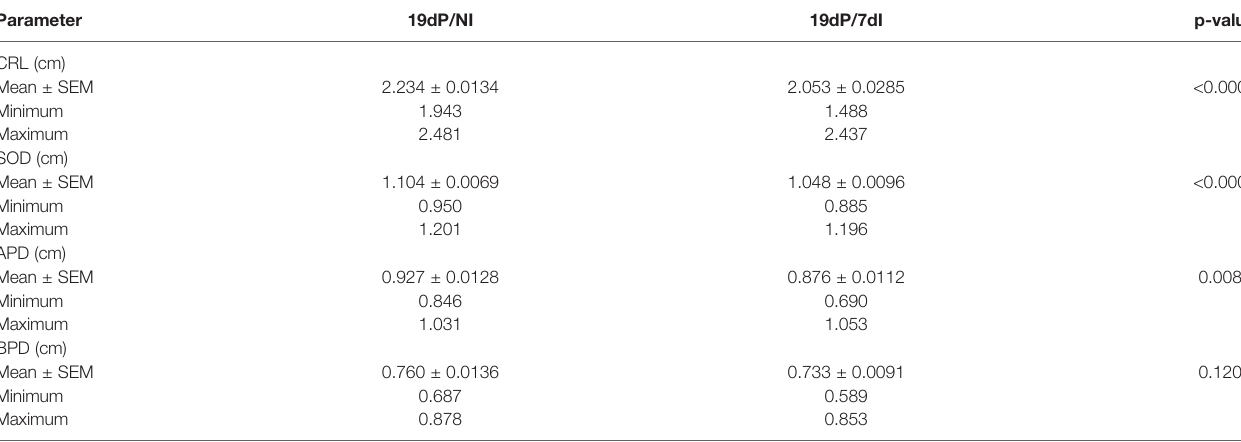
TABLE 1 | Fetal biometry measurements in fetuses of BALB/c mice infected or not with P. berghei